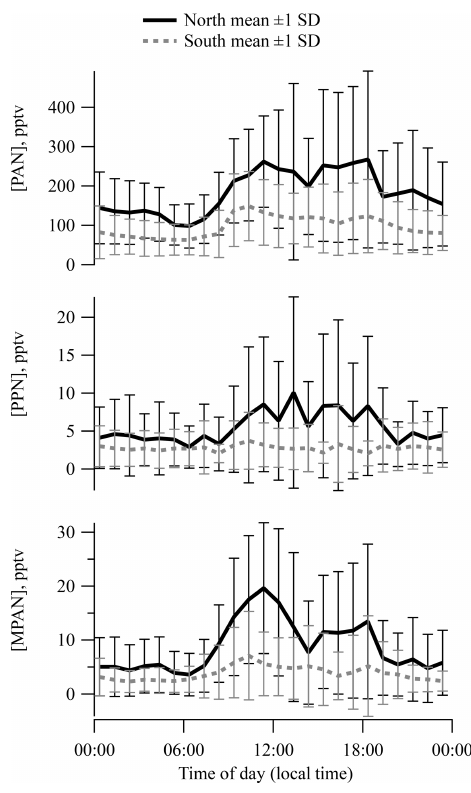
Figure 2. Diurnal behavior of PAN, PPN, and MPAN during SOAS 2013 with wind from the south and